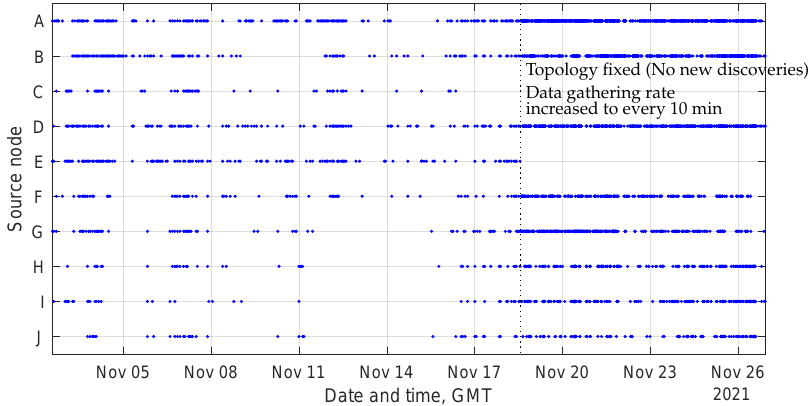
Figure 26. End-to-end packet delivery timeline from the North Sea deployment. It shows long periods of node outage, when the gateway could not connect to several nodes.